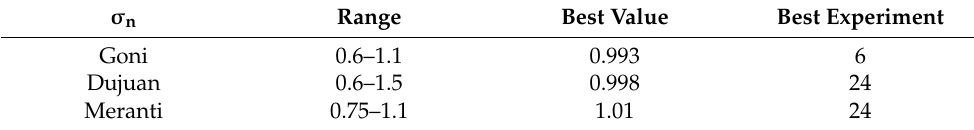
Table 10. σ n statistics of the wind direction simulation in the three typhoon events.